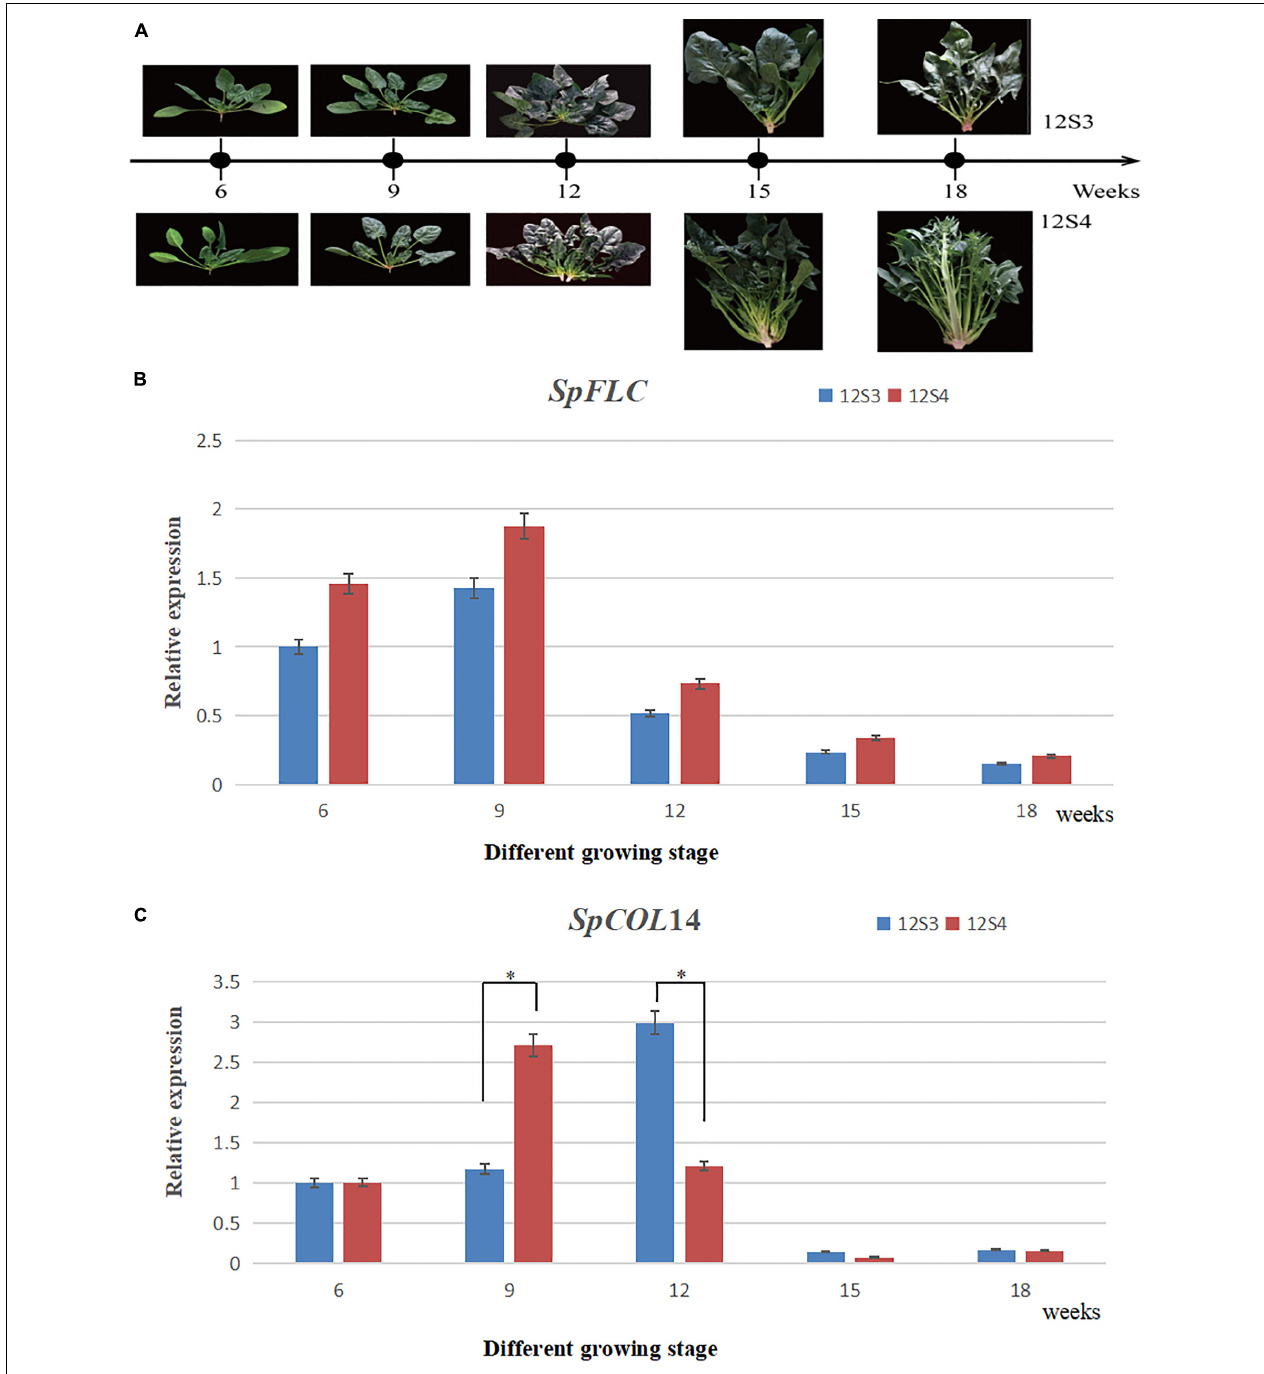
FIGURE 7 | (A) Plant materials used in qRT-PCR planted in 2021 spring; (B) the expression of SpFLC ; (C) the expression of SpCOL14 . * Represented significant difference ( P <